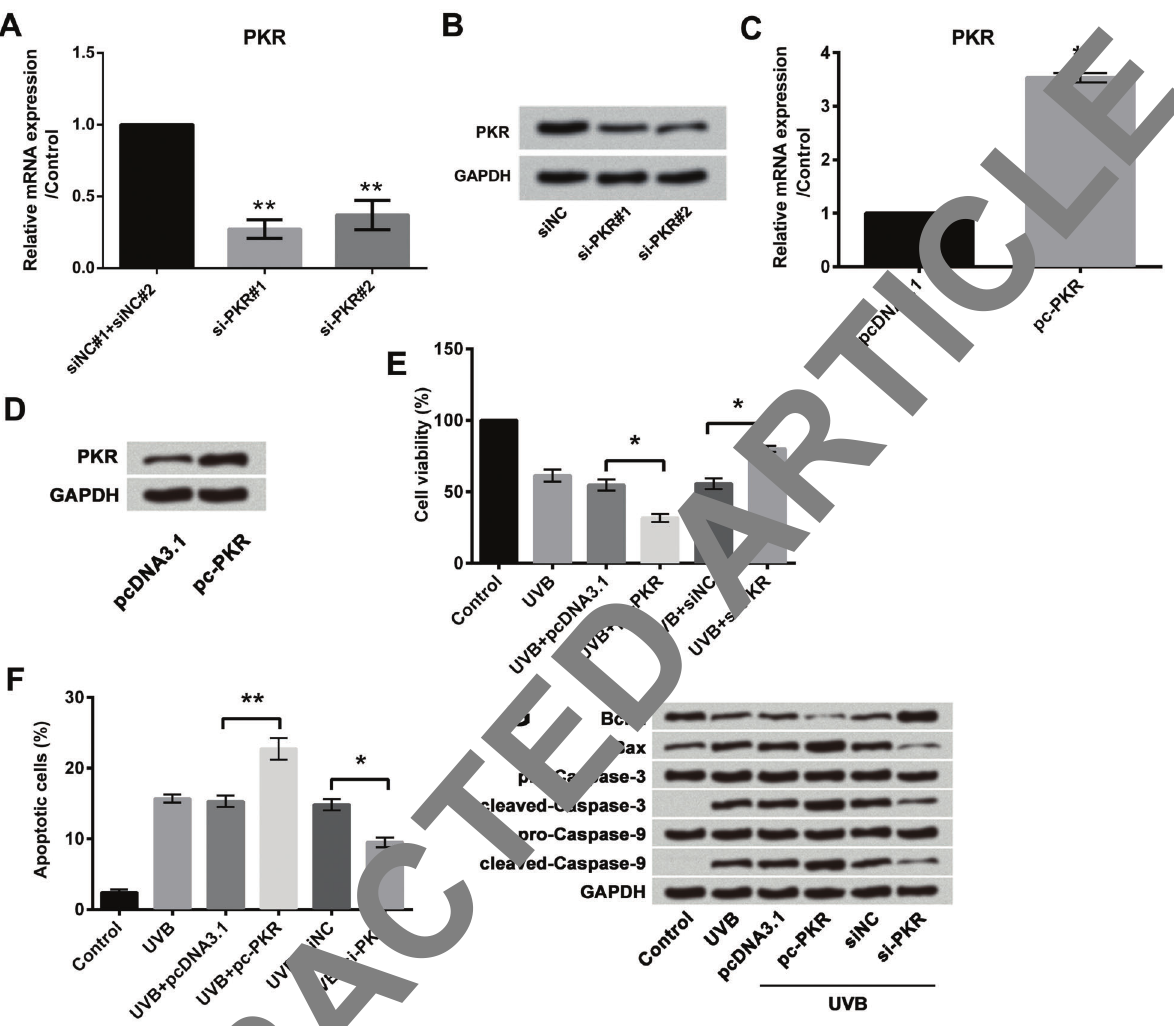
Figure 5. Effect of PKR on UVB-induced cell injury; A qRT-PCR revealed downregulation of PKR in HaCaT cells; B, Western blotting analysis revealed downregulation of PKR in HaCaT cells; C , qRT-PCR revealed overexpression of PKR in HaCaT cells; D , Western blotting analysis revealed overexpression of PKR in HaCaTcells; E , Cell viability assay revealed overexpression of PKR promoted UVB- induced cell viability inhibition, and the effects were reduced by suppression of PKR; F , Apoptosis assay revealed overexpression of PKR promoted UVB-induced cell apoptosis, and the effects were reduced by suppression of PKR; G , Western blotting analysis revealed overexpression of PKR promoted UVB-induced alterations in apoptosis-associated factors, and the effects were reduced by suppression of PKR. Data are reported as means ± SD. *P o 0.05; **P o 0.01 (ANOVA). UVB treatment time was 16 h. PKR: RNA- dependent protein kinase; UVB: ultraviolet B; qRT-PCR: quantitative real-time polymerase chain